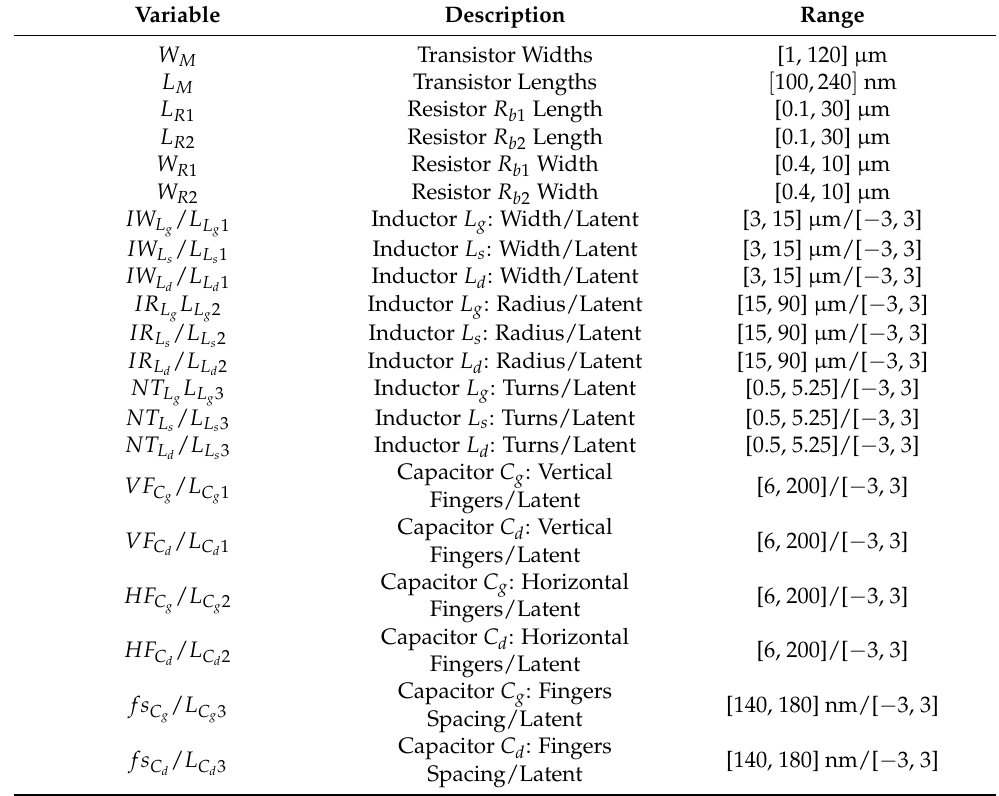
Table 1. LNA Variable